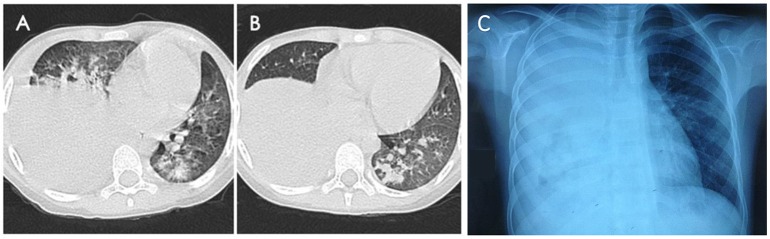
Chest imaging revealed high-density consolidation in right lung (A,B) with right pleural effusion (C) in RMPP patients.